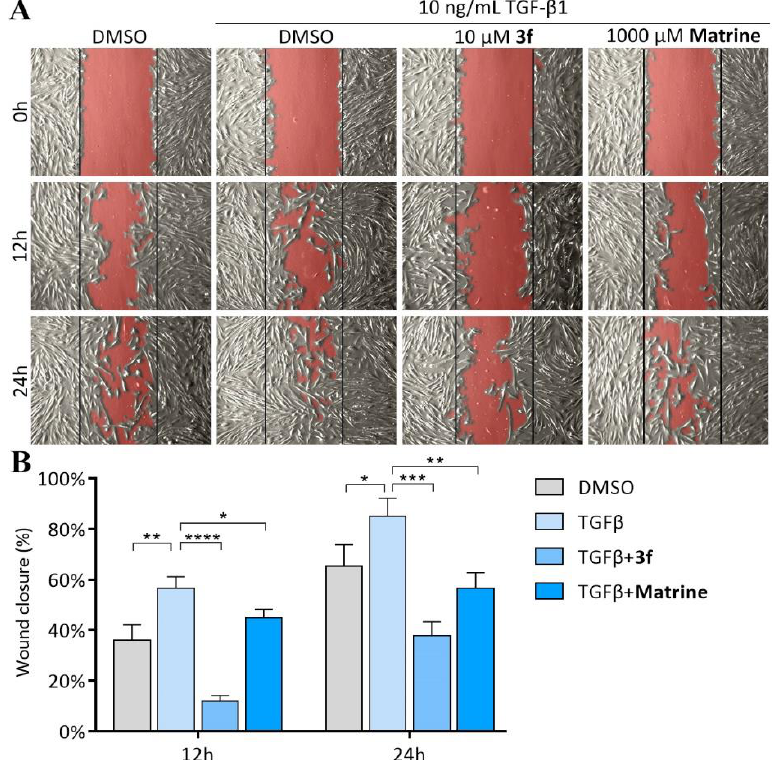
Figure 7. Effects of compound 3f and matrine on inhibiting TGF- β 1-induced MRC-5 fibroblasts migration. ( A ) Microscopic picture taken on 0 h, 12 h, and 24 h, the open area of wound region was highlighted in red; ( B ) Percentage of closure of wound area, analyzed by ImageJ software and MRI would healing tool plugin. Data are presented as mean ± SD of three individual experiments. * p < 0.05, ** p < 0.01, *** p < 0.001, **** p < 0.0001 vs . TGF β group.